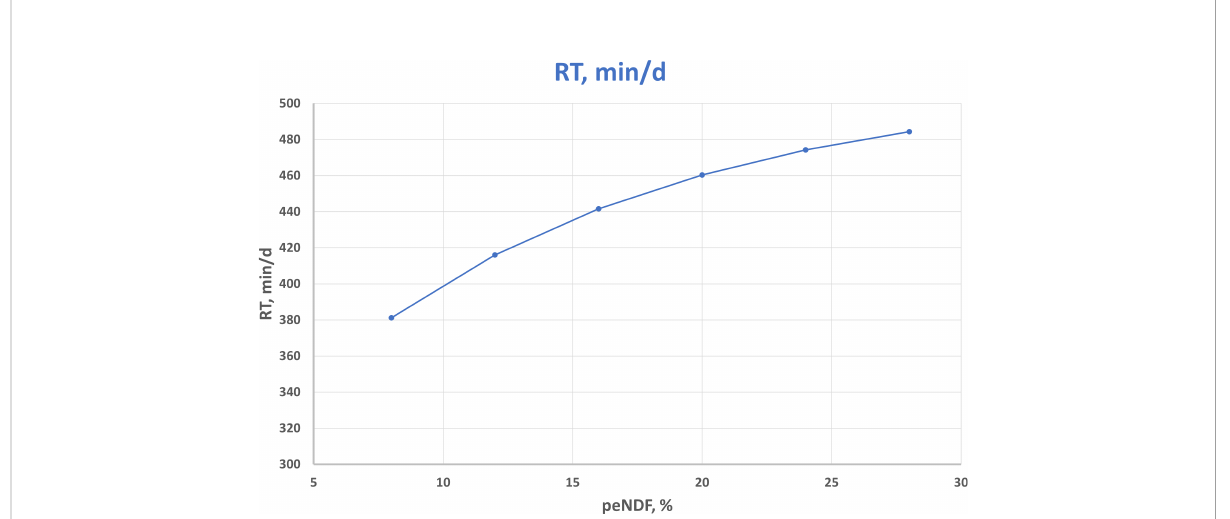
FIGURE 3 Relationship between physically effective NDF (peNDF) and rumination time in dairy cow according to the equation by Zebeli et al. (2012) where rumination time (RT, min/day) = 512.7 – 243.0 * exp -0.0768 * peNDF(%)